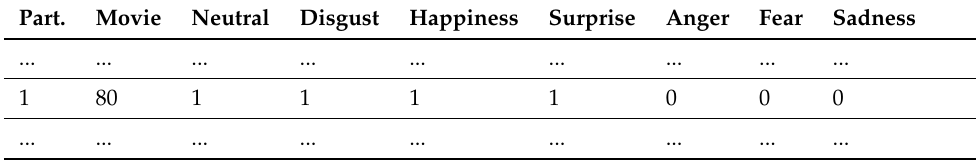
Table 5. Matrix row representing emotions detected by Face Reader for the first participant watching the 80th video. Part.